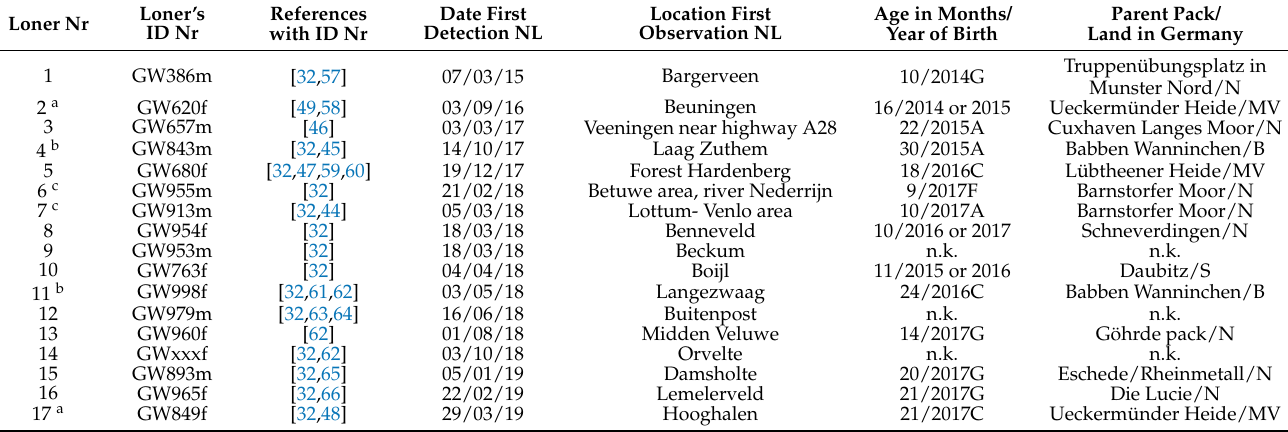
Table 1. Identified loners that have entered the Netherlands (NL), numbered chronologically with their ID number (nr) based on DNA analyses (f: female; m: male), references of loners including ID numbers, date and location of first detection in the Netherlands, age, year of birth and method of age determination (G: first genetic detection; A: autopsy; C: capture in the pack; F: first litter; without a letter: uncertain) and location of parent pack (N: Niedersachsen; MV: Mecklenburg-Vorpommern; B: Brandenburg; S: Sachsen; n.k.: not known).